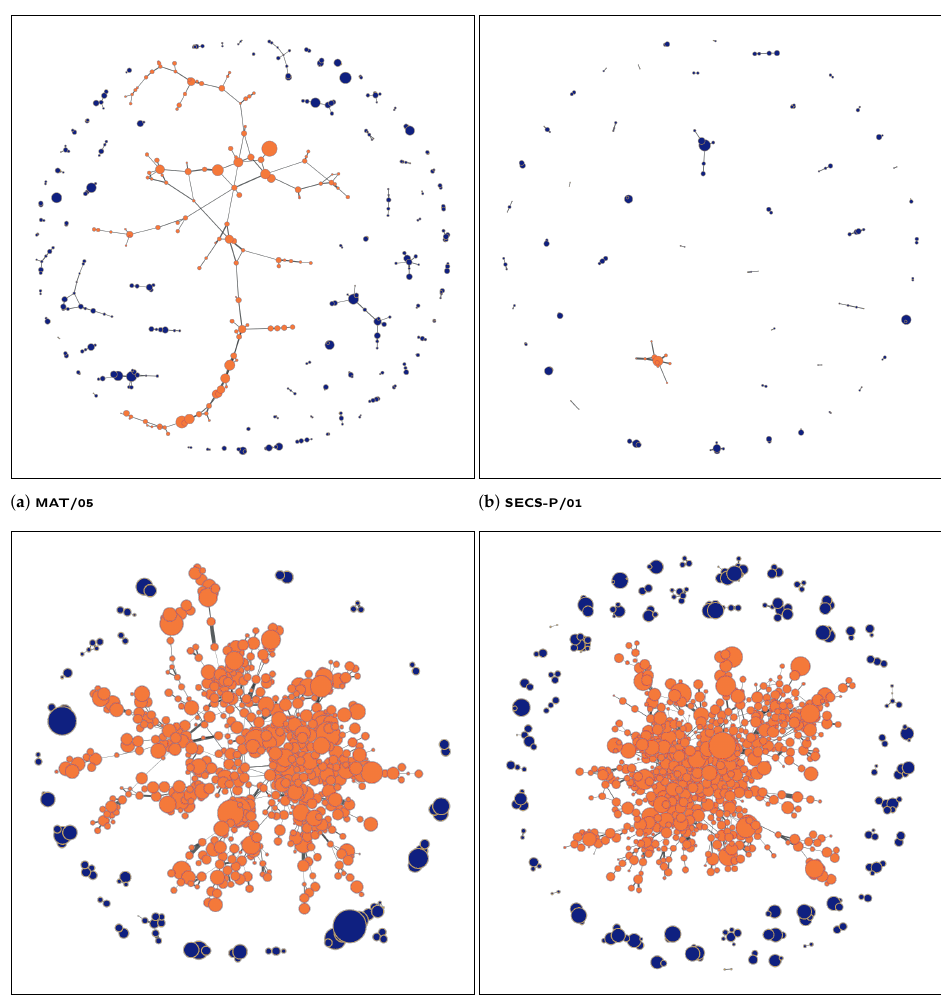
Figure 3. Italian academics’ co-authorship networks at depth-0. Vertices and edge widths are proportional to the author’s H-index edge weights, respectively. The Giant Connected Component colored in orange/clear. For sake of readability, the nodes with degree d i < 5 have been filtered